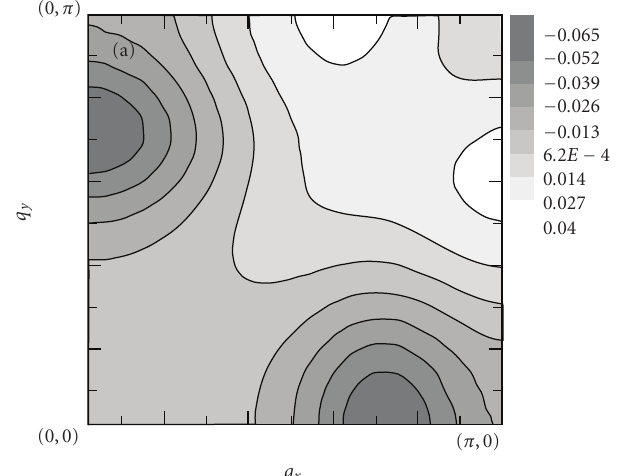
Figure 21: Contour map of the e ff ective paring interaction F(qW) calculated from the t-J model with the o ff -diagonal coupling case and the vertex correction (from